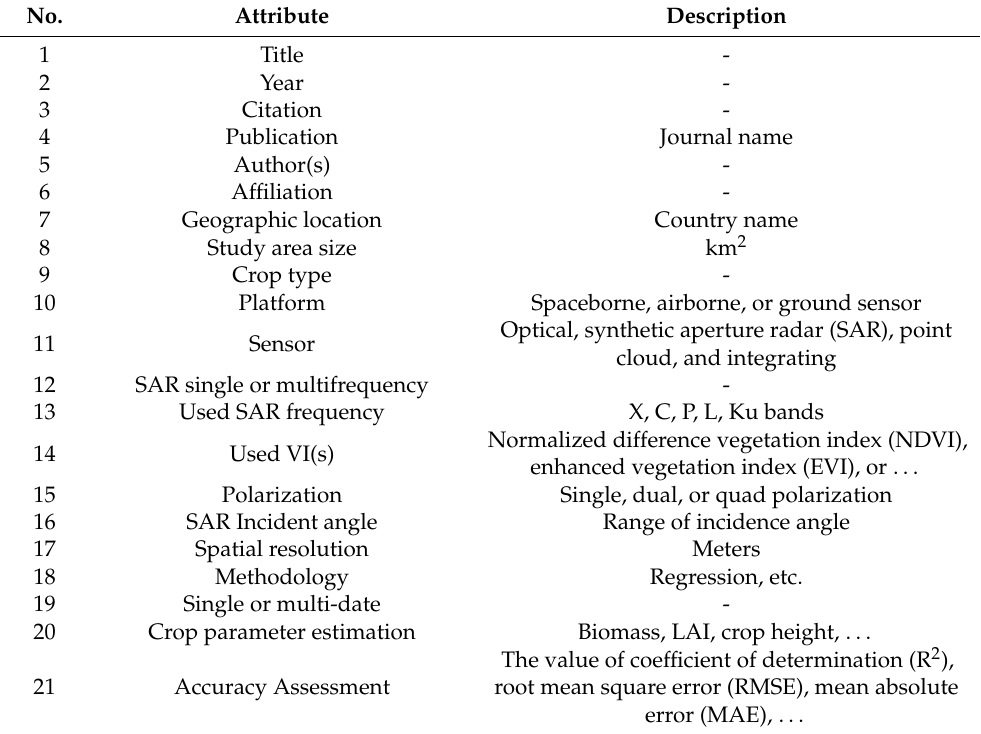
Table 2. Attributes extracted from screened articles in the database for comprehensive meta-analysis. These attributes were imported into an excel sheet for further